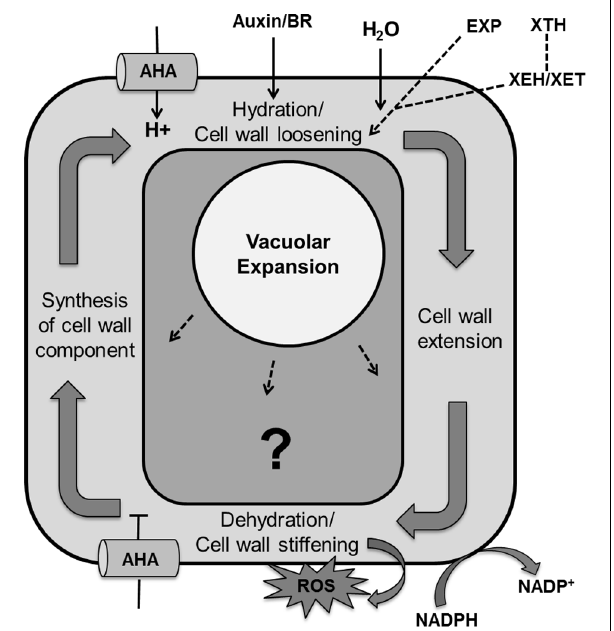
FIGURE 9 | Regulation of the cell expansion process with unknown molecular mechanism. Cell expansion is the result of vacuolar enlargement as well turgor driven cell wall yielding. The vacuole expands while taking up water and solutes whereas turgor driven cell wall yielding is the result of multiple steps, including hydration and cell wall loosening, cell wall extension by turgor pressure, dehydration/cell wall stiffening by release of apoplastic reactive oxygen species, cross-linking and dehydration and lastly synthesis and accumulation of cell wall components. Cell wall loosening is controlled by expansin (EXP) proteins and the xyloglucan endohydrolase (XEH) and xyloglucan endotransglucosylase (XET) activities of xyloglucan endotransglucosylase/hydrolases (XTHs). Auxin and brassinosteroid (BR) enhance activity of P-type plasma membrane proton ATPase (AHA; pointed and T shaped arrows indicate positive and negative regulation and question mark shows the unknown regulation,